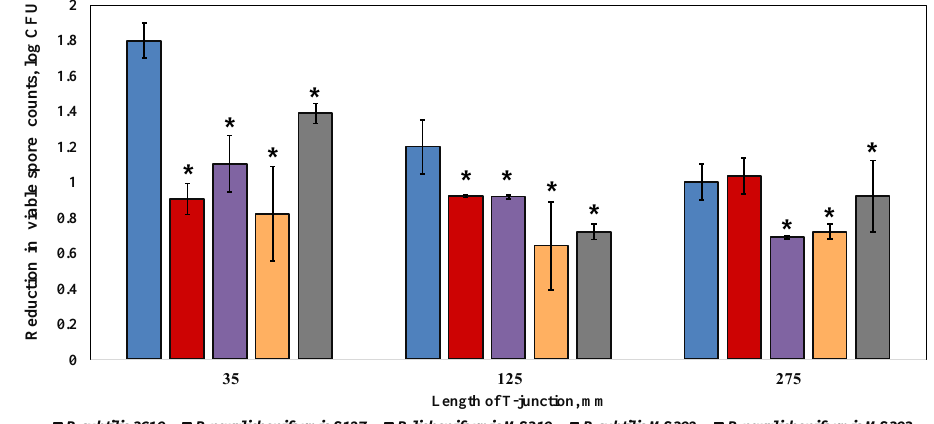
Figure 2. E ff ect of the cleaning procedure with tap water on the removal of biofilm-derived spores of the dairy-associated Bacillus in the CIP model system. Sampling plates, each containing approximately 2 million spores of B. subtilis 3610 or dairy Bacillus isolates, were mounted on T-junctions, protruding 35, 125, and 275 mm from the main loop of the CIP model system, and cleaned in the installation. Tap water, without the addition of any detergent, was used as the cleaning agent. A basic assumption was the similar adhesion e ffi ciency of the spores of each tested strain in di ff erent experimental repeats (since the spores were obtained using previously validated experimental procedures [21]). The cleaning e ff ect was evaluated by comparing the number of viable spores (attached to the sampling plates), before and after cleaning. The results represent the means and standard deviations (SD) of two independent biological experiments, performed in triplicate. * Statistically significant di ff erence ( p < 0.05) between the reduction in the viable spore counts of a given sample and the reduction in the spore counts for B. subtilis 3610 (control).